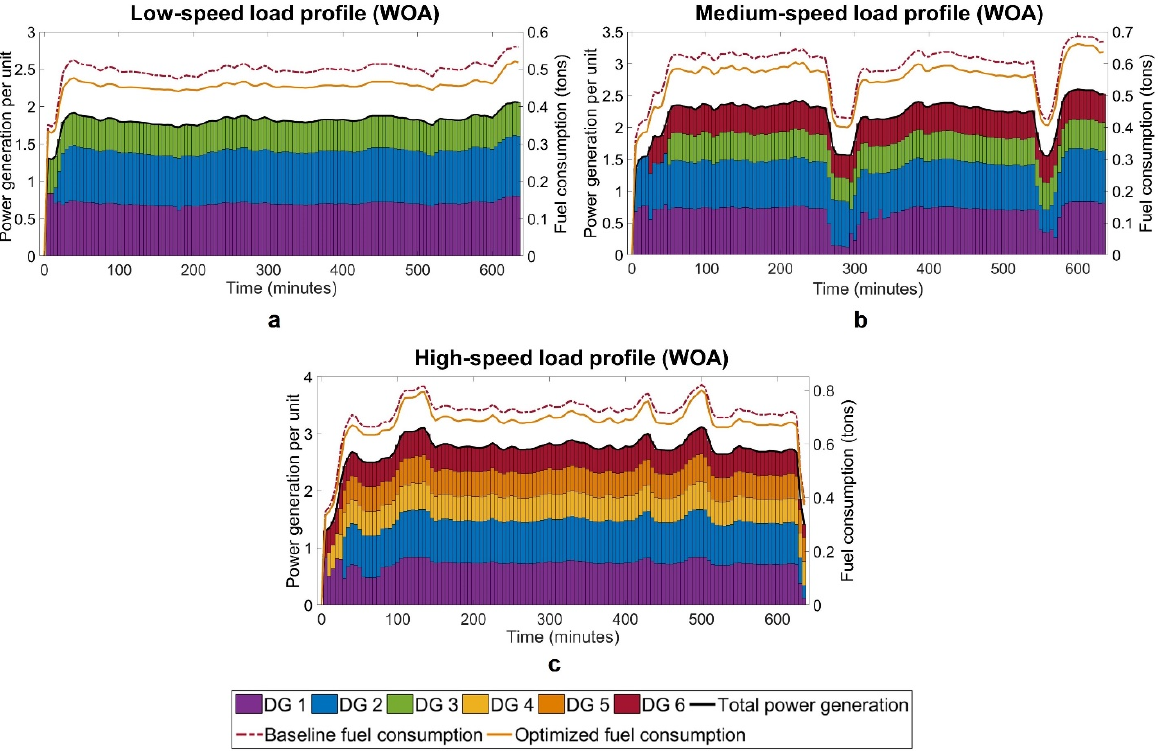
Figure 13. Optimization of the 6-DG system by using WOA with: ( a ) low-speed profile ( b ) medium-speed profile ( c ) high- speed profile.